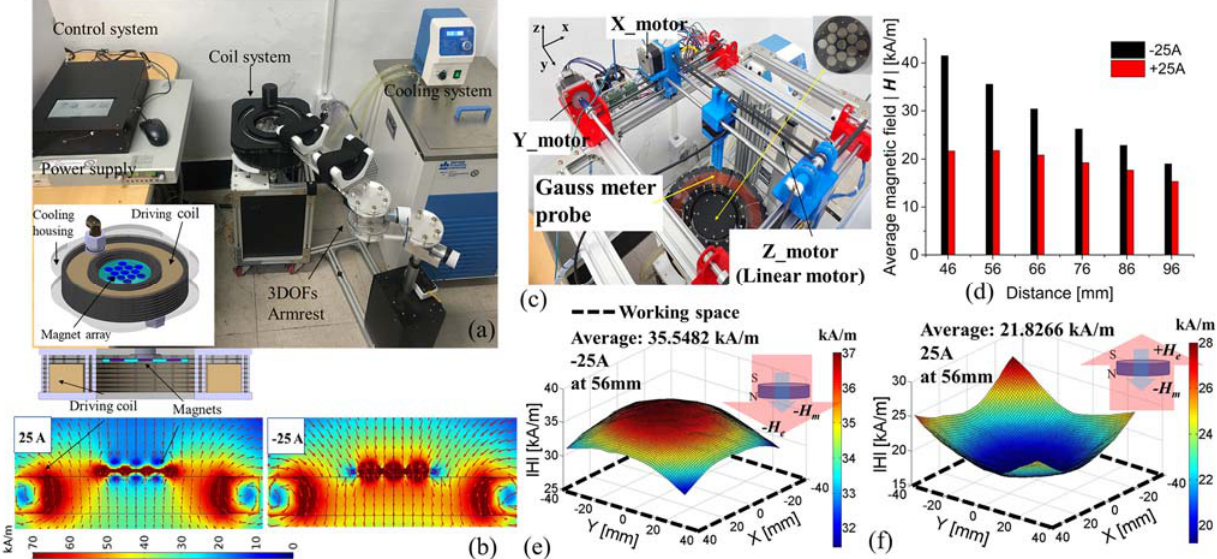
Figure 3. Control system analysis using magnetic simulation and magnetic field measurement: ( a ) control system configuration; ( b ) simulation results including M3 at 25 and − 25 A; ( c ) developed three-axis measurement system and LabView-based instrumentation software; ( d ) measured average magnetic field strength with − 25 and 25 A driving currents according to changes in height up to 96 mm; ( e , f ) field distributions for − 25 and 25 A, respectively, at 56 mm height: H e and H m are the magnetic fields of the electromagnets and M3 (permanent magnets), respectively. (see Video S2)